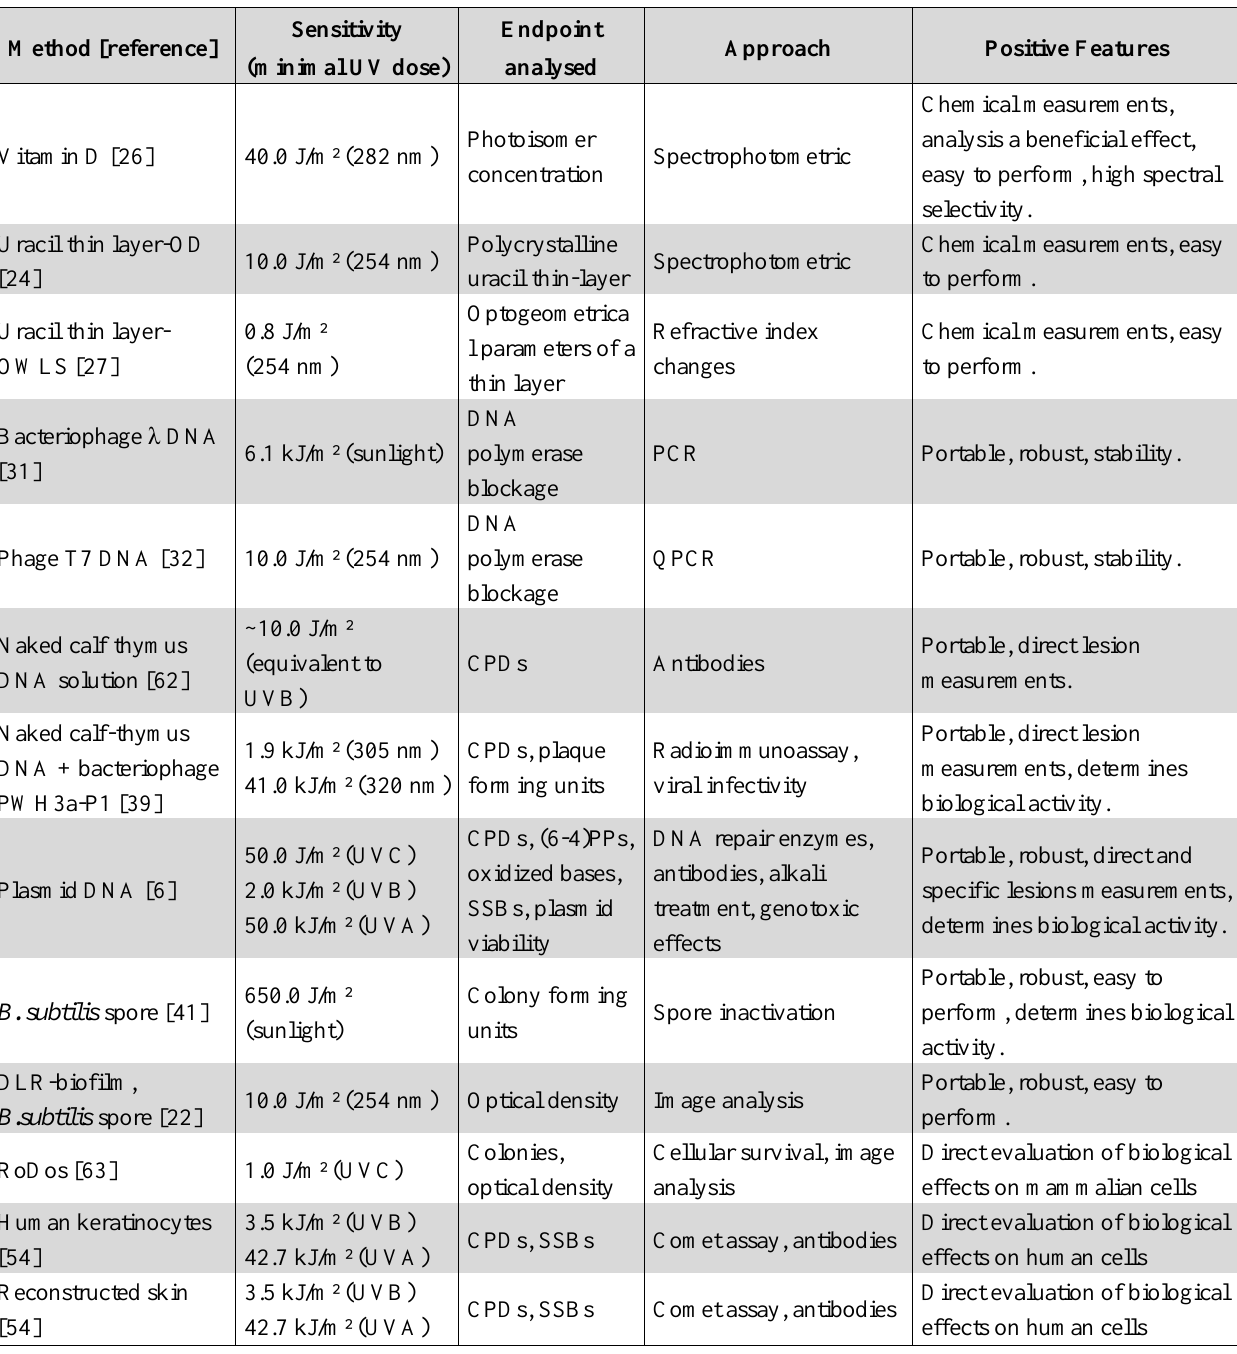
Table 1. Comparison of different